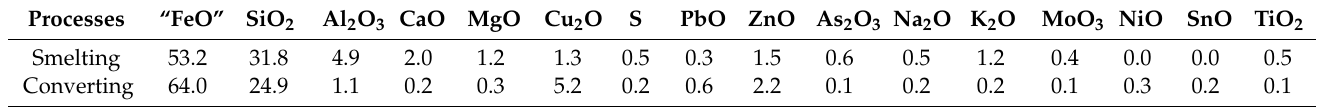
Table 1. Composition of quenched smelting and converting slags (wt.%).